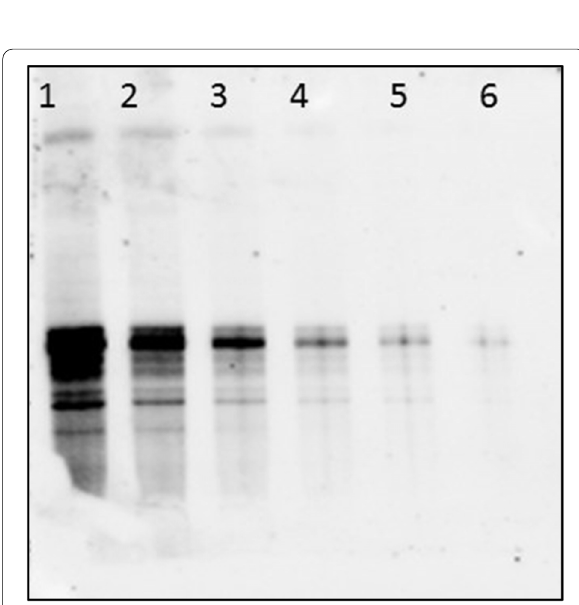
Fig. 9 Western blotting detection of CYP1A from protein extracts of mullet fish microsomes. Lane 1, 250 ng of protein extract; lane 2, 125 ng; lane 3, 62.5 ng; lane 4 3.12 ng; lane 5 1.56 ng; lane 6 0.78 ng. Rabbit IgG anti CYP1A was used as the primary antibody at a dilution ratio of 1:7500 in TBS/1% casein. SA-TRIM21 at 0.25 μg/mL was added to the nitrocellulose membrane in TBS/1% casein for rabbit IgG recognition. Biotin HRP (1:2500) was added followed